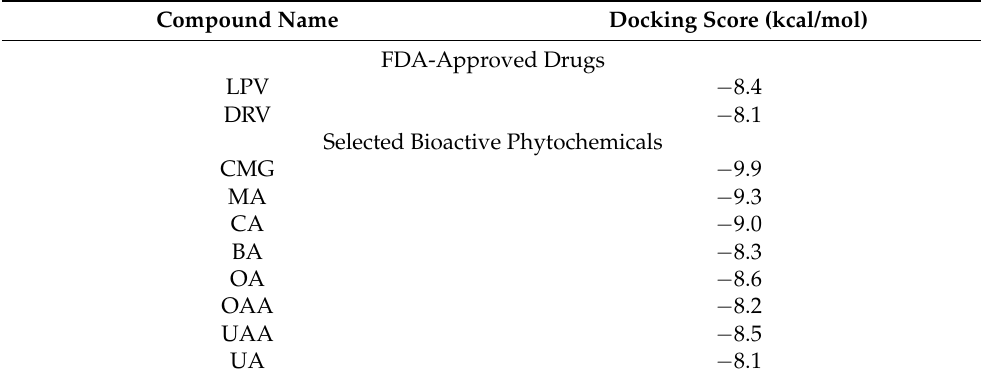
Table 1. Docking scores for the two FDA-approved HIV-1 protease inhibitors and selected bioactive phytochemical